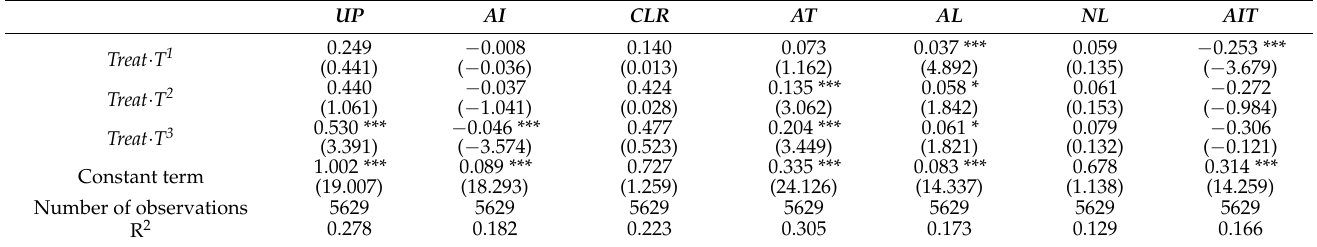
Table 7. Test results of the impact of a households’ part-time farming on the grain output